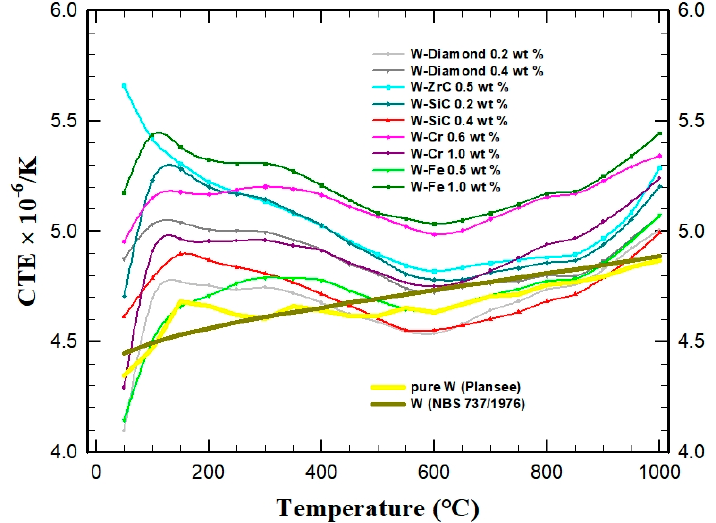
Figure 10. Temperature-dependent CTEs of selected W − dispersion composites. For comparison, values obtained for typical pure W materials are also included.